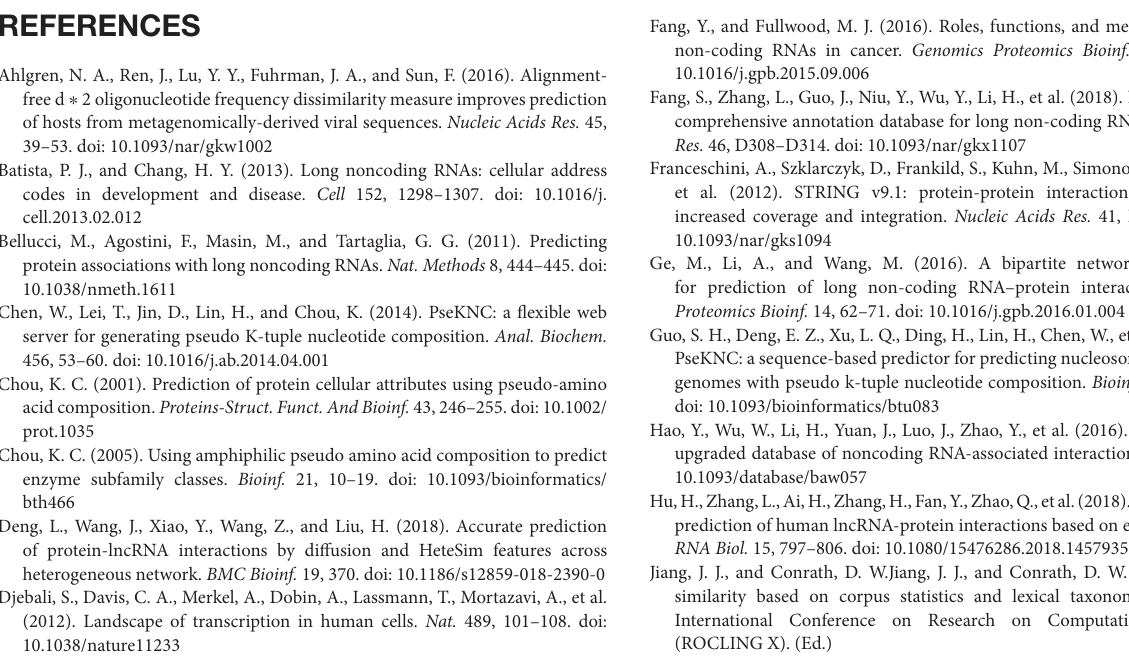
s1 TABLe | Prediction results of 95 new proteins by SFPEL-LPI and PMDKN. s1 FILe | Eps format for all pictures in the manuscript. s2 FILe | The code and data of